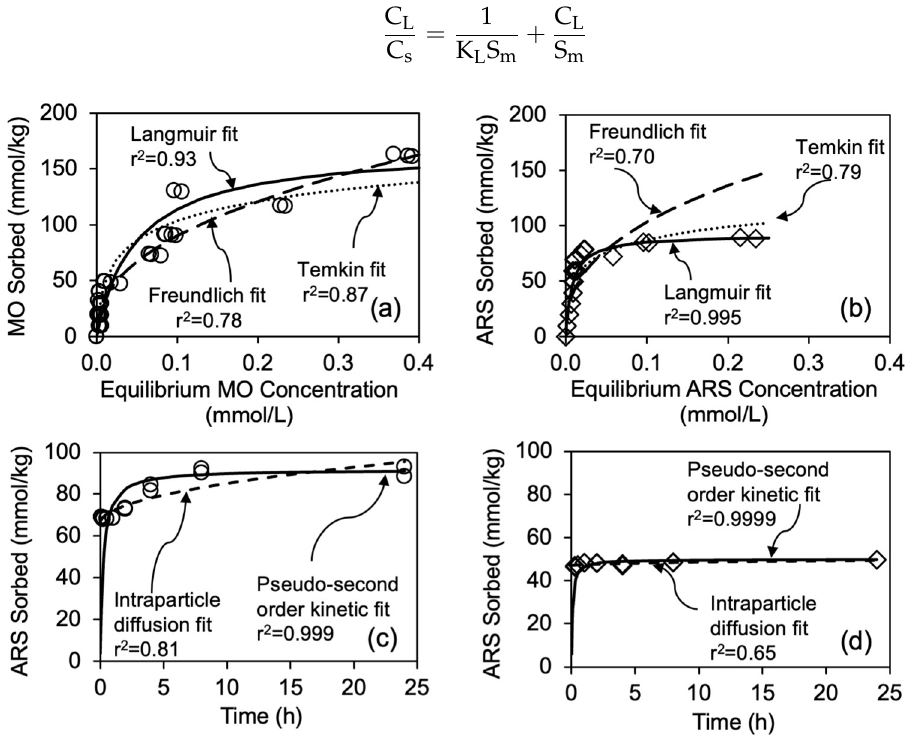
Figure 2. Isotherm study of MO ( a ) and ARS ( b ) and kinetic study of MO ( c ) and ARS ( d ) sorption on zeolite.